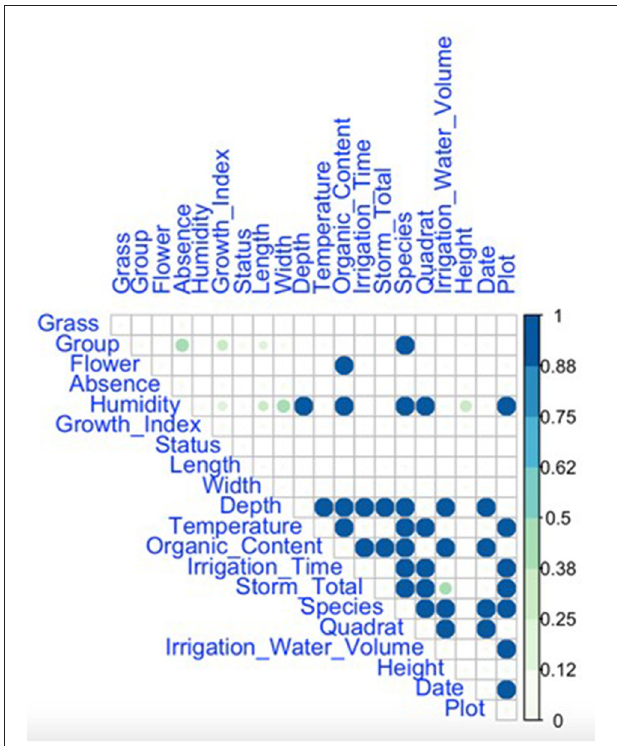
FIGURE 4 | A pairwise correlation plot for all parameters considered in the study. The color and size of the circle denotes the magnitude of the correlation value. Highly correlated parameters were considered to be those with absolute correlation values > 0.7. Source: